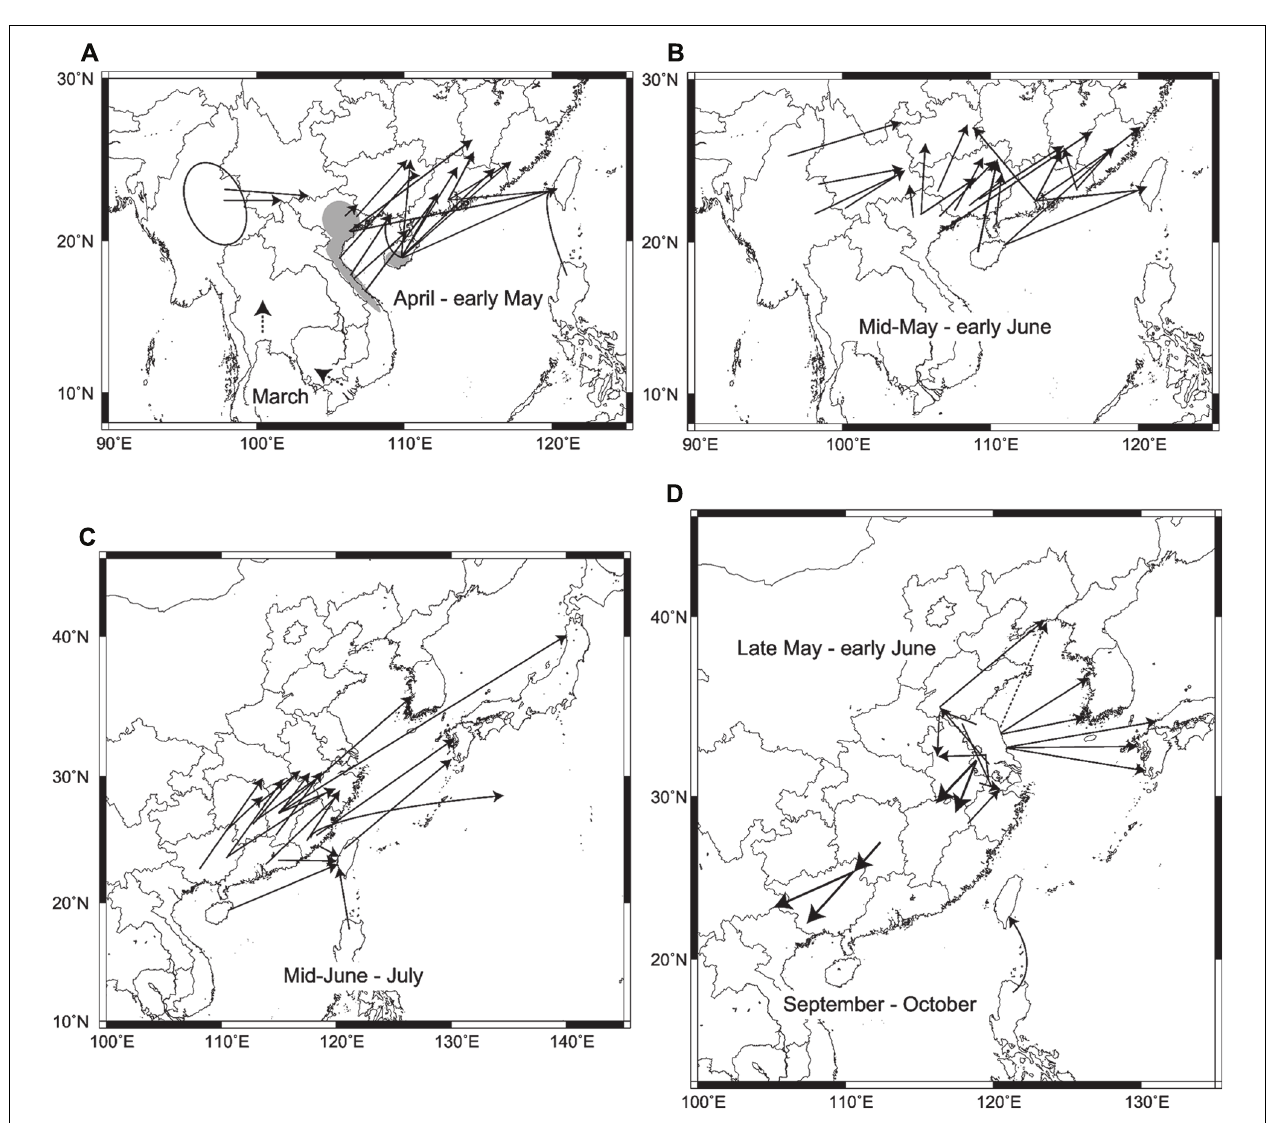
routes of N. lugens and S. furcifera from mid-June to July. Data from Turner etal. (1999); Hua etal. (2002), Otuka etal. (2005); Zhao etal. (2011a), Zheng etal. (2011); Diao etal. (2012), and Otuka (2012), (D) routes of Laodelphax striatellus from late May to early June, return migration routes of N. lugens in September to October, and a route from the Philippines to Taiwan by a typhoon in September. The dashed arrow shows the hypothetical route based on Zhou and Cheng (2012). Data from Riley etal. (1991), Otuka (2009), Qi etal. (2010b), Wang etal. (2011a); Zhang etal. (2011), Jiang etal. (2012); He etal. (2012), Otuka etal. (2012a,b), and Zhou and Cheng